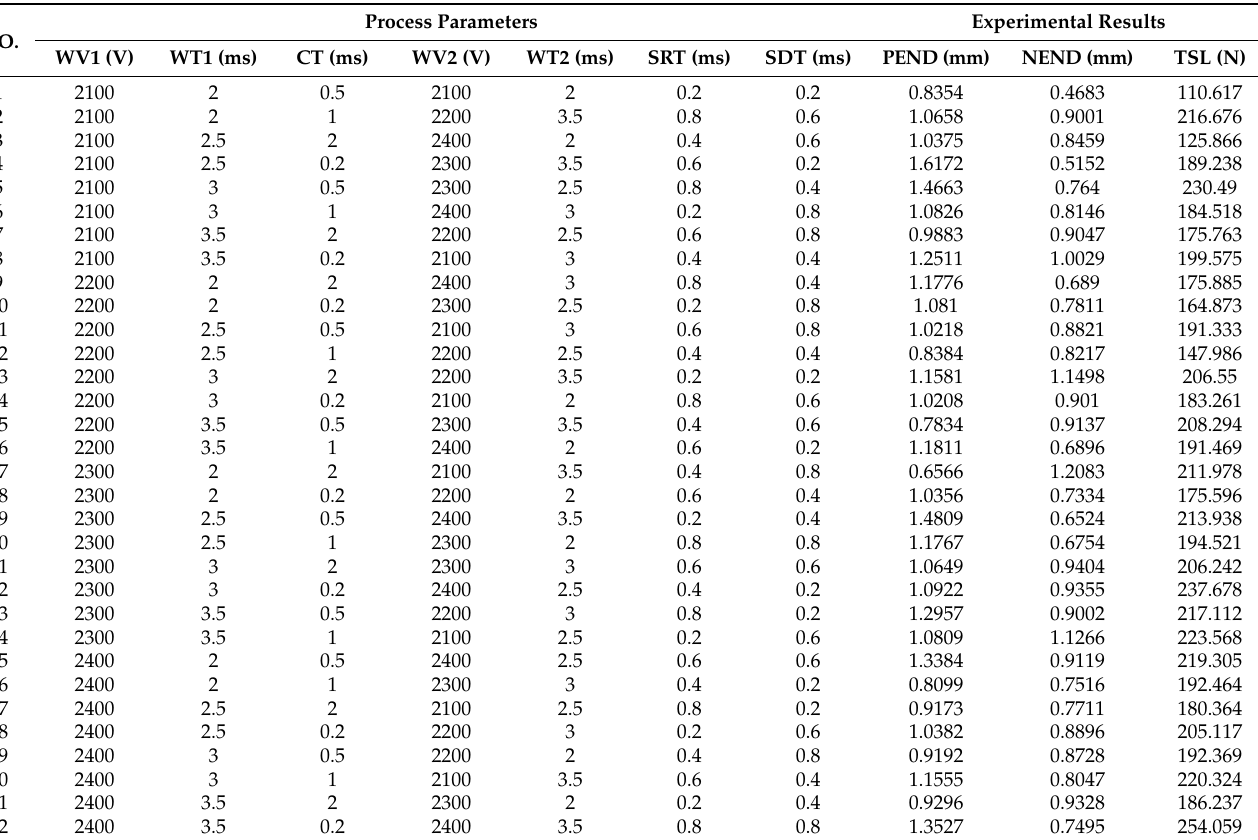
Table 3. L 32 orthogonal experiments and the corresponding experimental results.